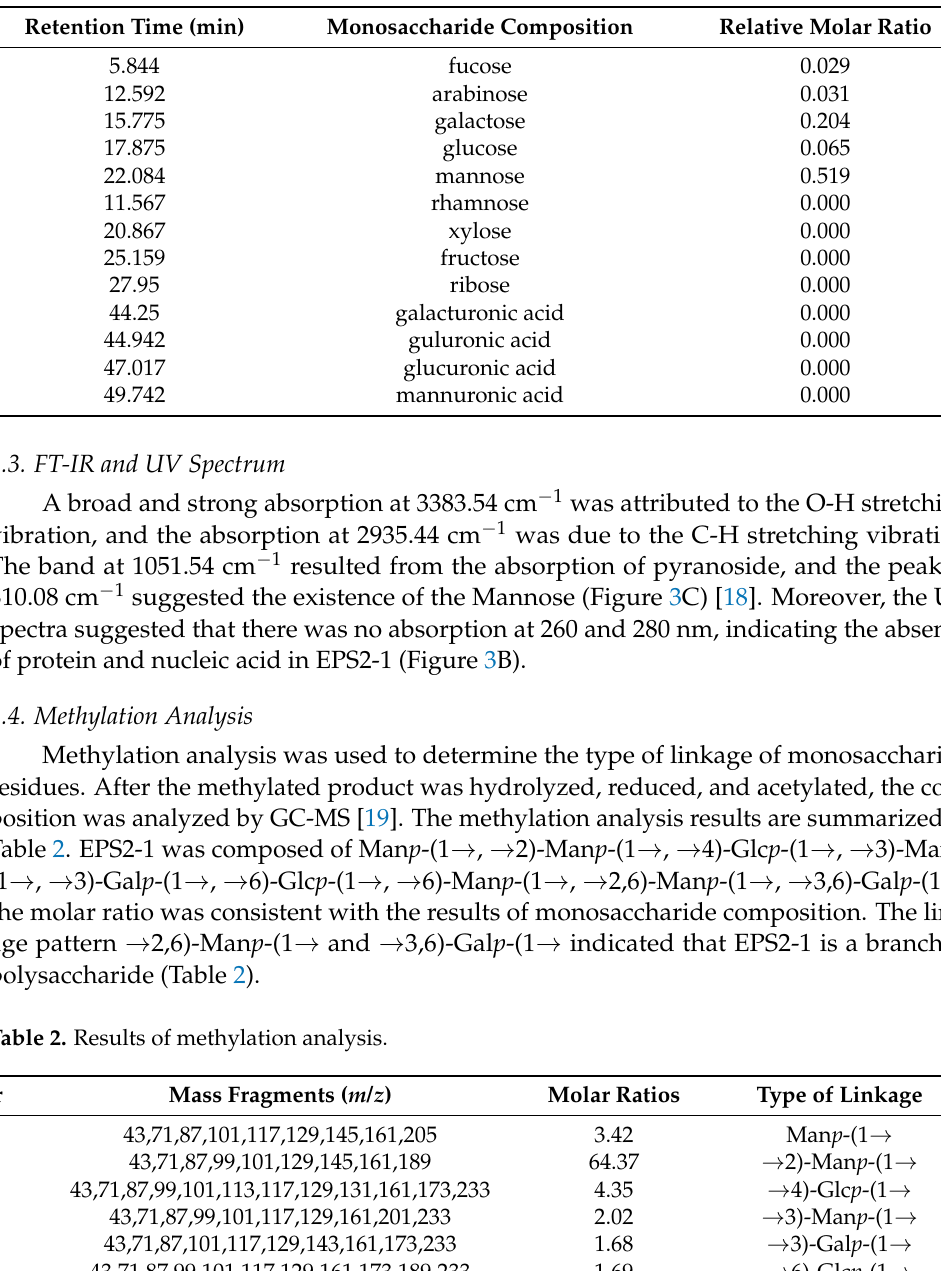
Table 1. Monosaccharide composition analysis of EPS2-1.